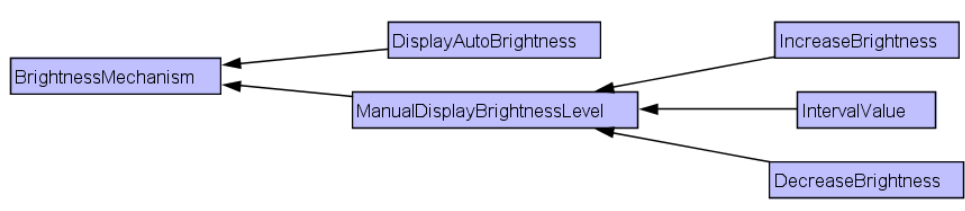
Figure 3. Brightness Mechanism Ontology made with CoGui editor.